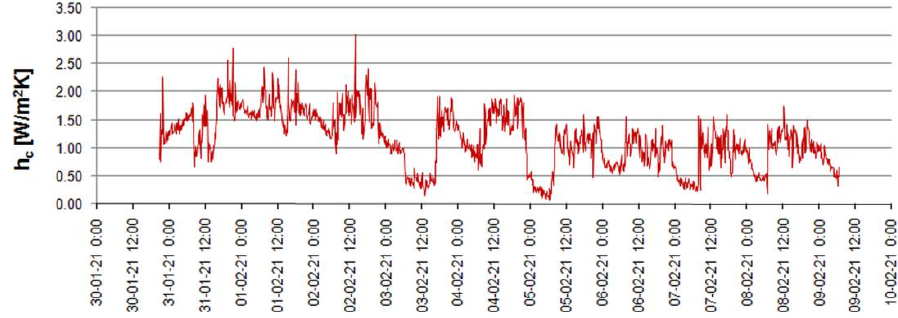
Figure 8. Convective heat transfer coefficient from measurements.